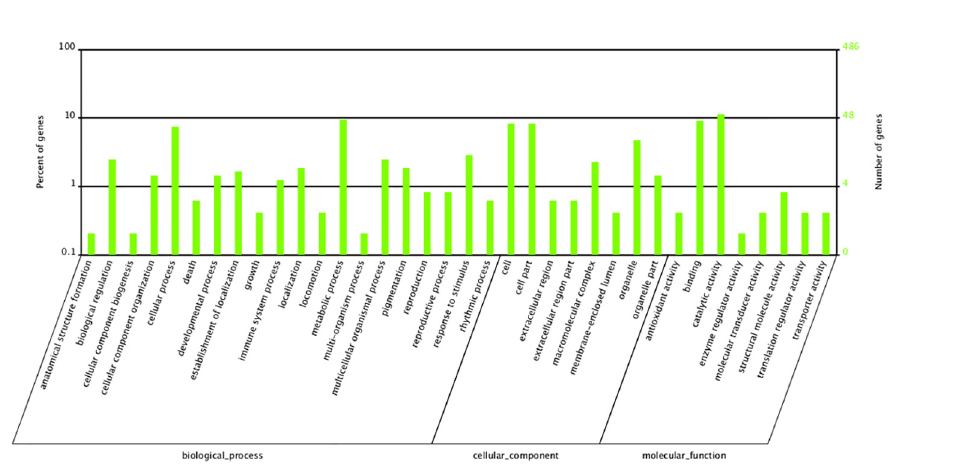
Fig 3. GO annotation of AG proteins in E . sinensis . The subcellular locations and functions of the identified proteins were determined by their GO component and function terms, respectively, available for download as text-based annotation files from the GO database ftp site: ftp://ftp.geneontology.org/